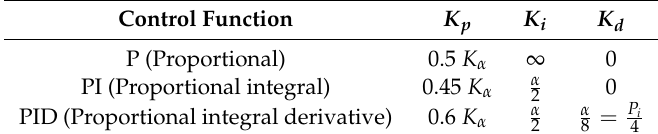
Table 4. Conditions for the controller parameters in the Ziegler–Nichols’ closed loop technique.